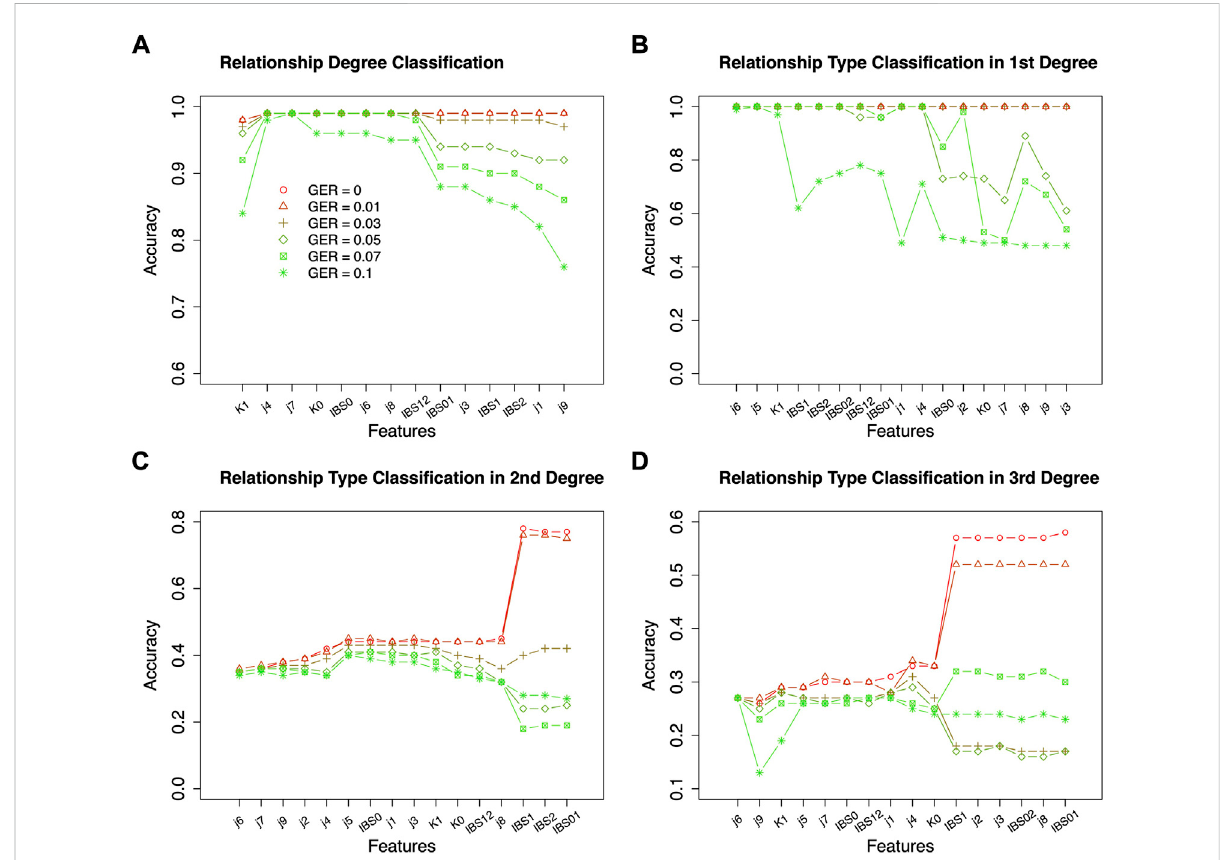
FIGURE 5 Classi fi cation accuracies with the selected features ranked as in Figures 3, 5 for relationship degree and types using data simulated with various genotyping errors. GER = genotyping error rate of the test dataset. (A) the accuracies by the forward features selection for the relationship degrees, (B) the accuracies by the forward features selection for the 1st degree relationships, (C) the accuracies by the forward features selection for the 2nd degree relationships, (D) the accuracies by the forward features selection for the 3rd degree